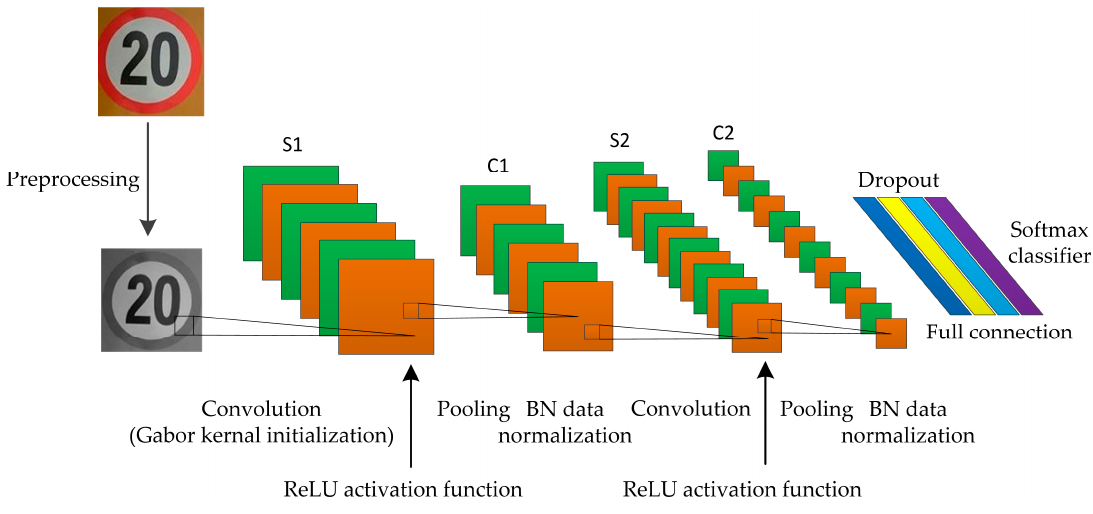
Figure 6. The improved LeNet-5 network model structure.